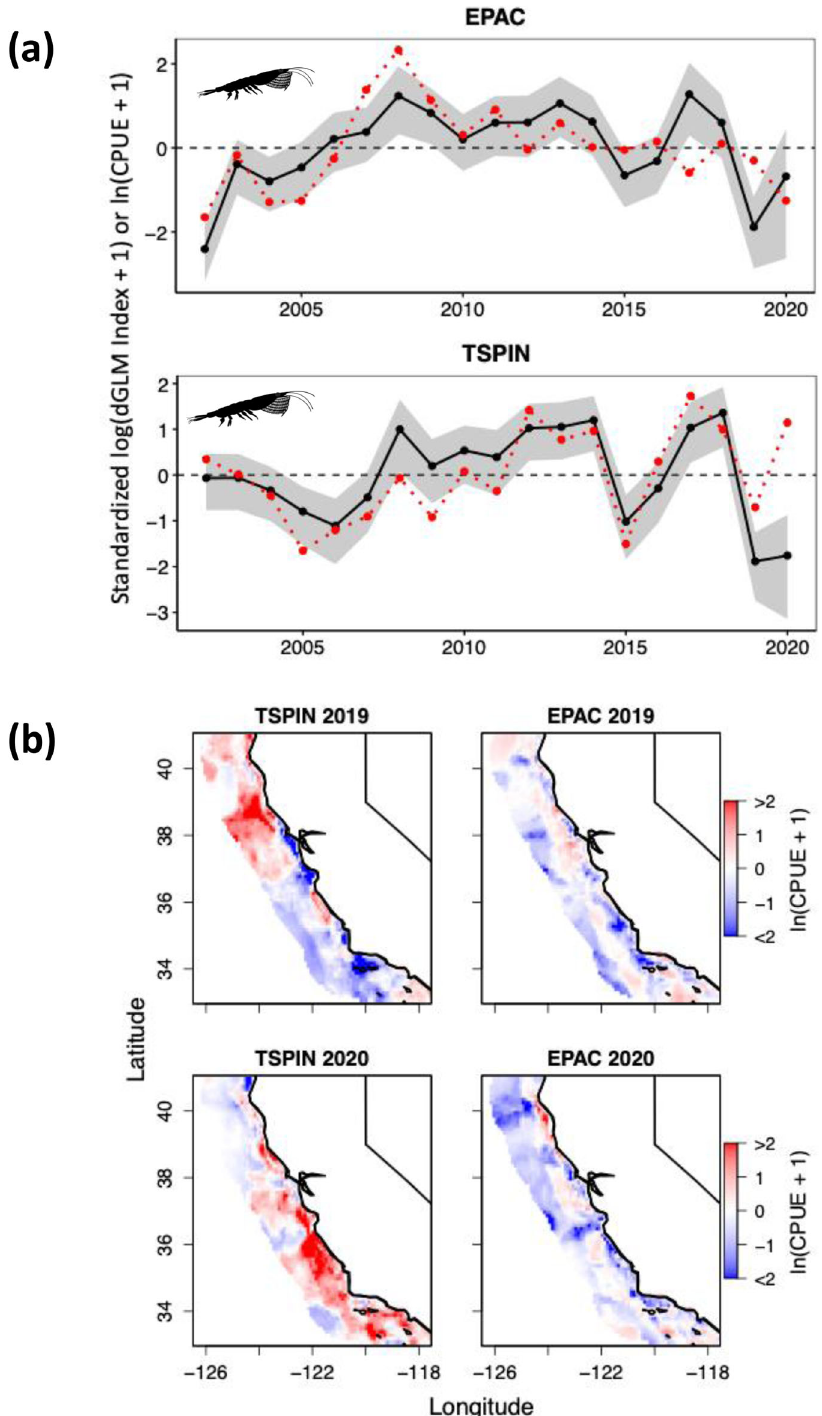
Fig. 4 Prediction of krill species distribution and abundance. a Interannual variation in standardized log(delta-GLM Index + 1) estimates (black line) and species distribution model (SDM) mean ln(CPUE + 1) (red dashed line) for T. spinifera (TSPIN) and E. paci fi ca (EPAC) from 2002 to 2020 within the core region. CPUE, catch-per-unit-effort. Error bands (shaded area) are 95% credible intervals. It is noteworthy that observations from the 2020 trawl survey are likely to be underestimated. b Spatial anomalies of predicted TSPIN and EPAC abundance from the mean CPUE climatology from 2002 to 2018 during 2019 and 2020. Red (blue) indicates higher (lower) than average CPUE and only predictions out to 150 km from shore are shown. See Supplementary Fig. 9 for mapped comparisons between predictions across this domain and station-level observations. Taxa silhouettes are derived from